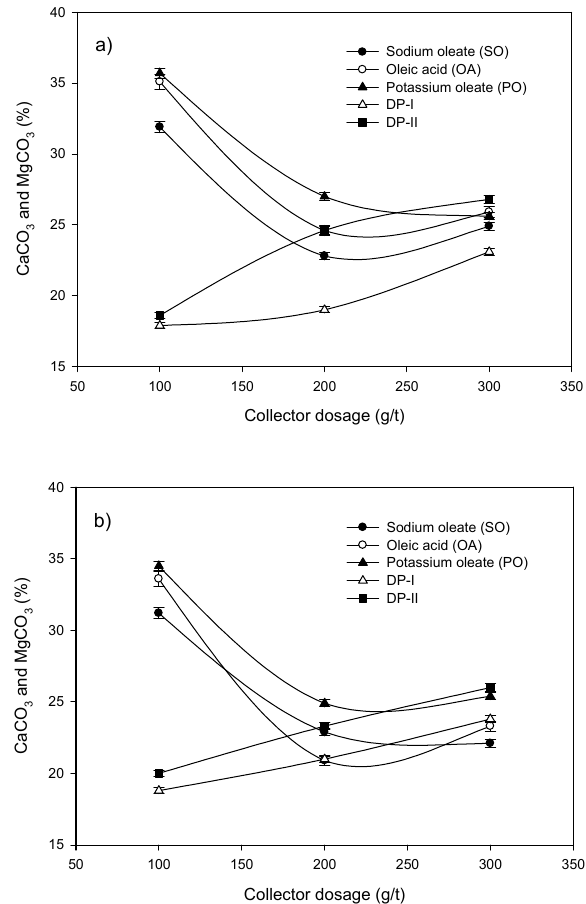
Figure 6. Effect of the collector dosage on the carbonates grade in the mechanical cell ( a ) and pneumatic cell ( b ) froth